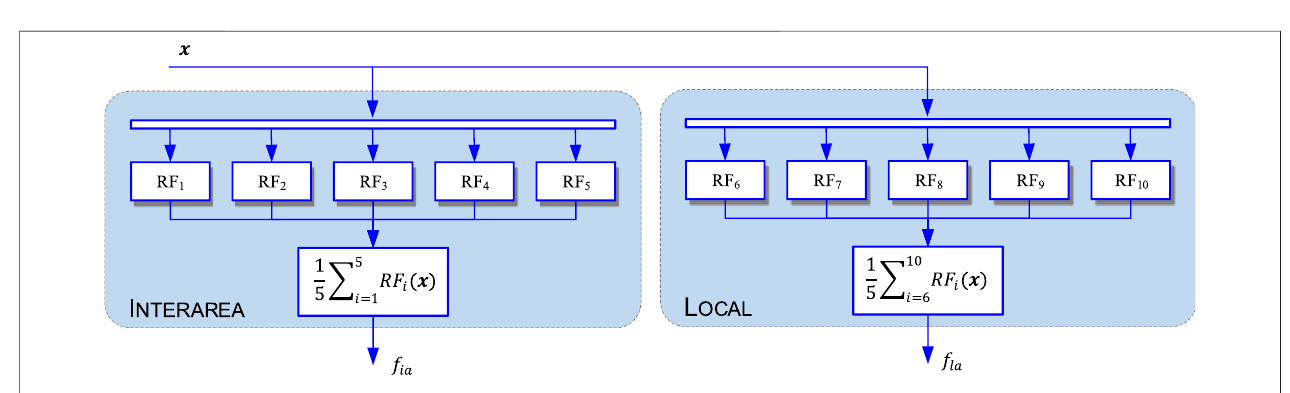
FIGURE 8 | Sample decision tree within random forests.